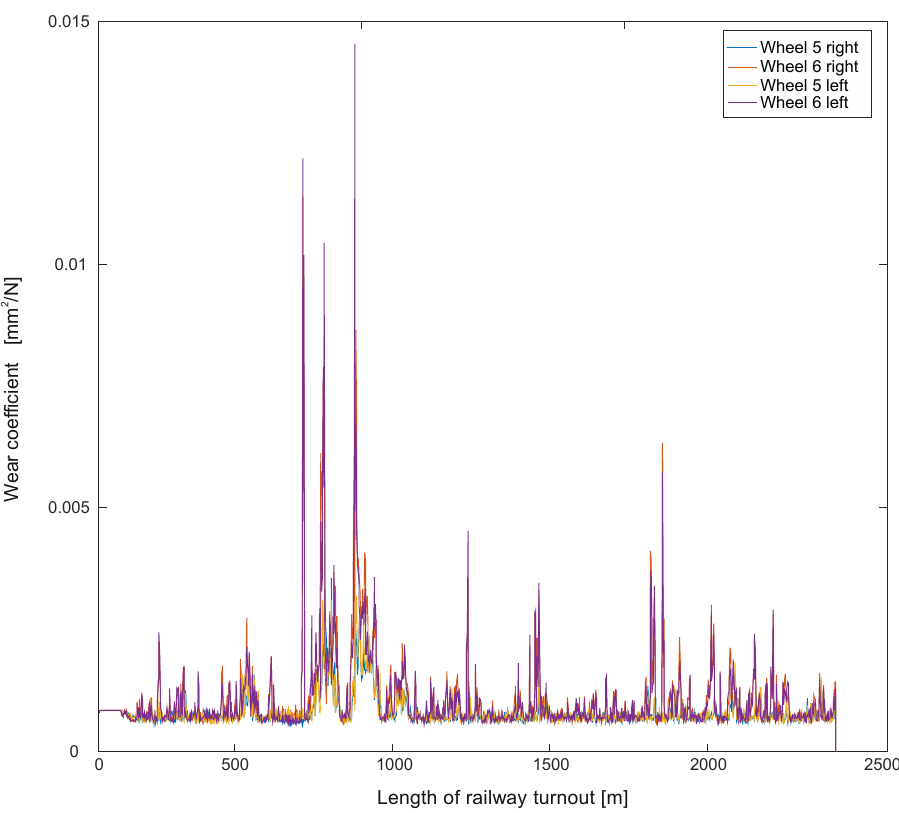
Figure 31 . Wear coefficient obtained for a straight track without a turnout at 200 km/h .